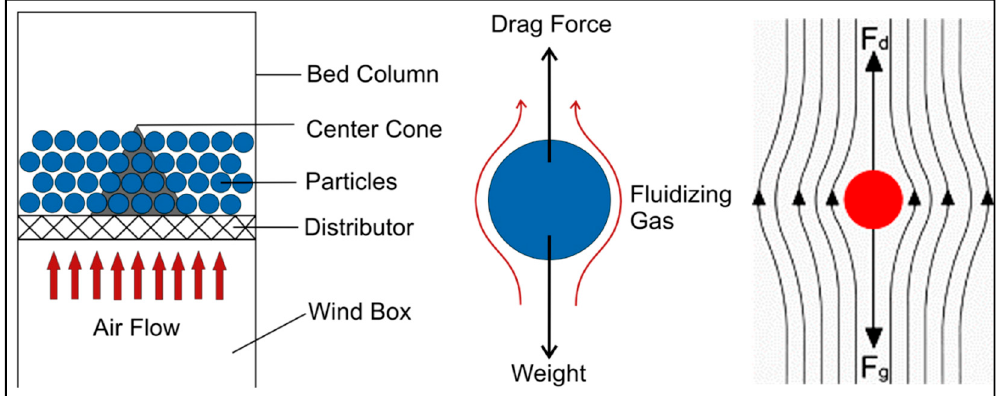
Figure 1. Illustration of a simple fluidization process in a fluidized bed column.